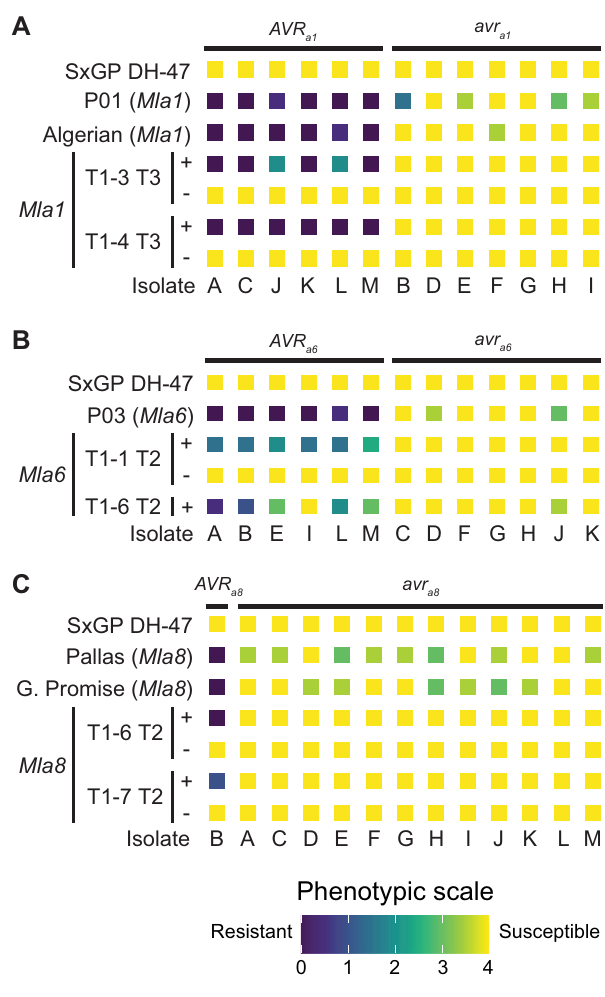
Fig. 4 Mla transgenes maintain race-speci fi c resistance to barley powdery mildew ( Blumeria graminis f. sp. hordei ). Independent transformants of barley cv. SxGP DH-47 with ( A ) Mla1 , ( B ) Mla6 , and ( C ) Mla8 driven by the Mla6 promoter and Mla6 terminator were inoculated with 13 diverse barley powdery mildew isolates. SxGP DH-47 was susceptible to all isolates. Single T-DNA insertions were suf fi cient to confer race-speci fi c resistance to barley powdery mildew for Mla1 , Mla6 , and Mla8 . Controls include Pallas ( Mla8 ), near-isogenic lines in the Pallas genetic background: P01 ( Mla1 ), P03 ( Mla6 ), Algerian ( Mla1 ), and Golden Promise ( Mla8 ). For individual Mla alleles, barley powdery mildew isolates are ordered based on the presence ( AVR ) or absence ( avr ) of an avirulence gene. Isolates include 3-33 ( A ), Race I ( B ), X-4 ( C ), I-167 ( D ), K-200 ( E ), M-236 ( F ), Z-6 ( G ), C-132 (H), 120 ( I ), R86/1 ( J ), K-3 ( K ), KM18 ( L ), and MN-B ( M ) 86 . All experiments were performed twice with similar results and data shown is the average of these experiments. Original data is provided as Supplementary Data